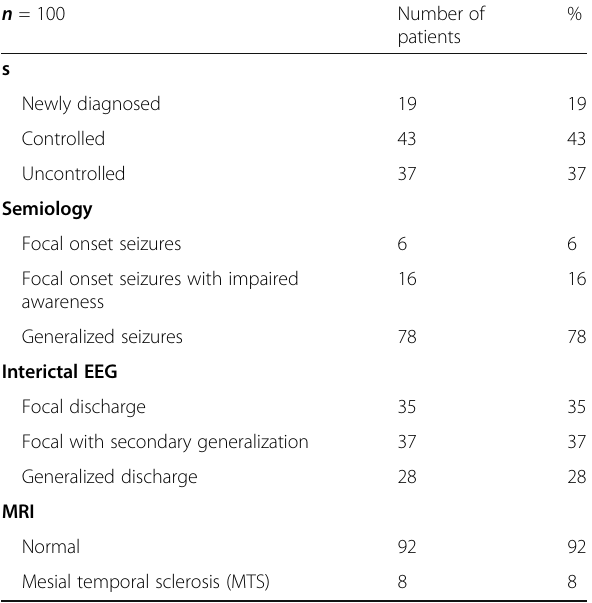
Table 2 Clinical, investigational, and radiological findings